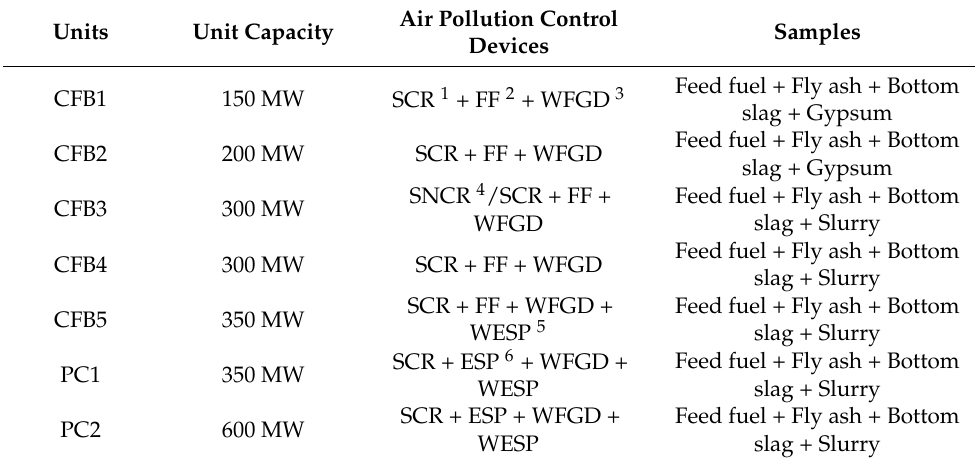
Table 1. Unit capacity, air pollution control devices and samples of coal-fired power units. Units